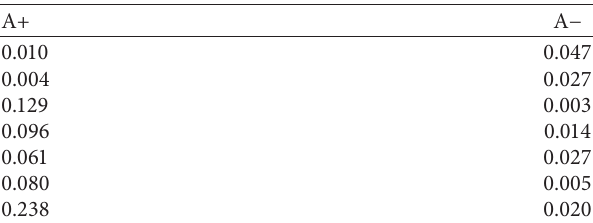
Table 6: Determination of positive ideal and negative ideal